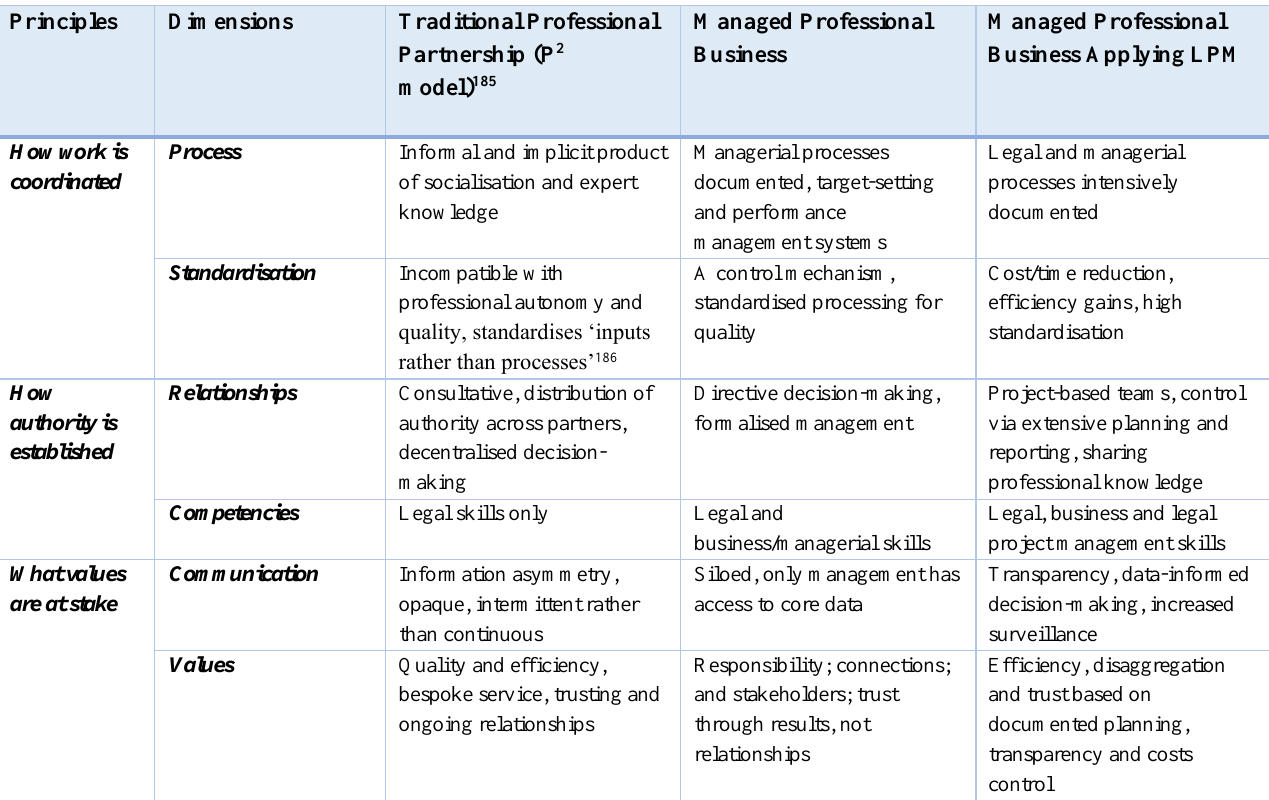
Table 3. A Comparison of Core Features of Professionalism in a Traditional Professional Partnership,